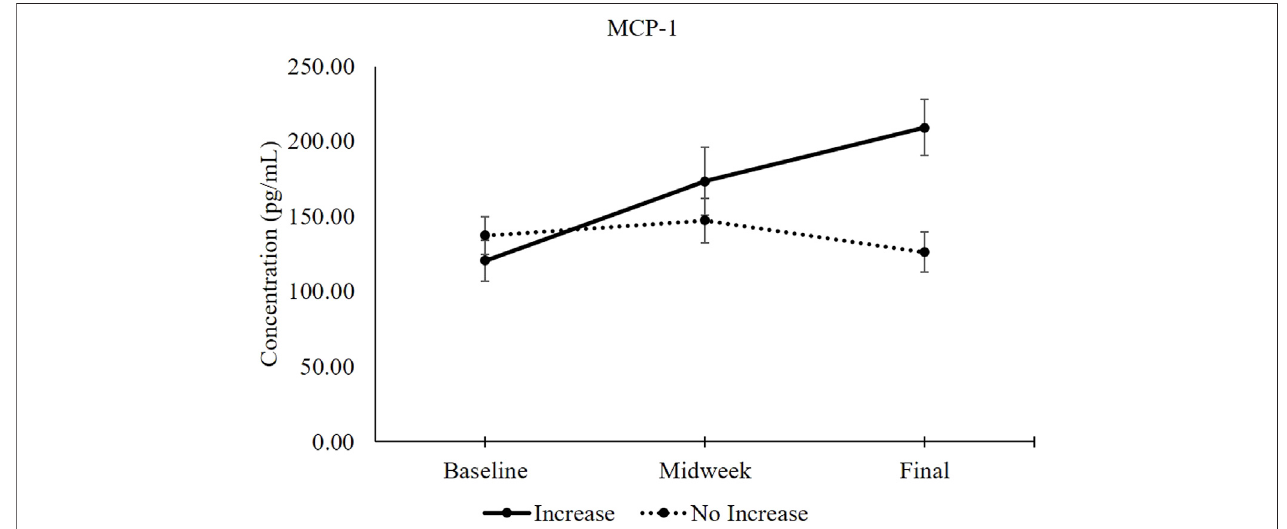
FIGURE 3 | MCP-1 serum levels between participants with increased General Fatigue ( n = 13) and without increased General Fatigue ( n = 9). The solid black line represents MCP-1 serum levels (mean ±1 SEM) in participants whose General Fatigue score increased between baseline and the study endpoint. The dotted black line representsMCP-1 serum levelsinparticipants whoseGeneralFatiguedid notincrease( Table5 ).Independent samples t -testcomparisons revealed2-tailed p -valuesof 0.404 at baseline, 0.345 at midweek and 0.004 at the study endpoint.